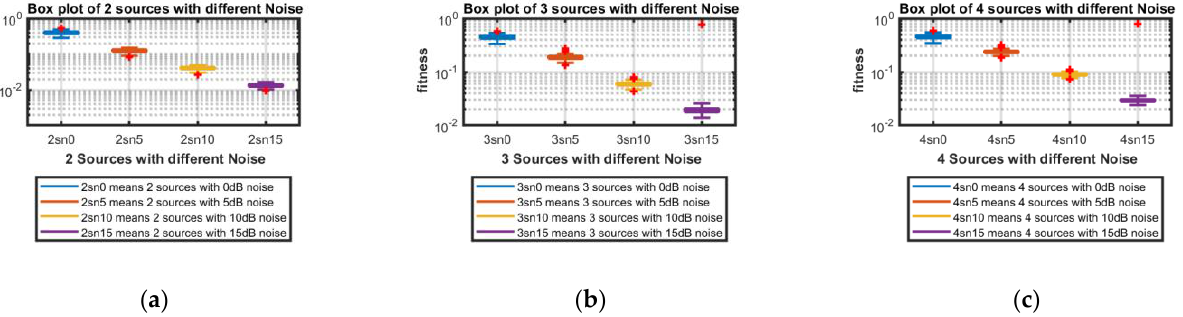
Figure 10. Box Plot with Different Noises: ( a ) Two Sources; ( b ) Three Sources; ( c ) Four Sources.